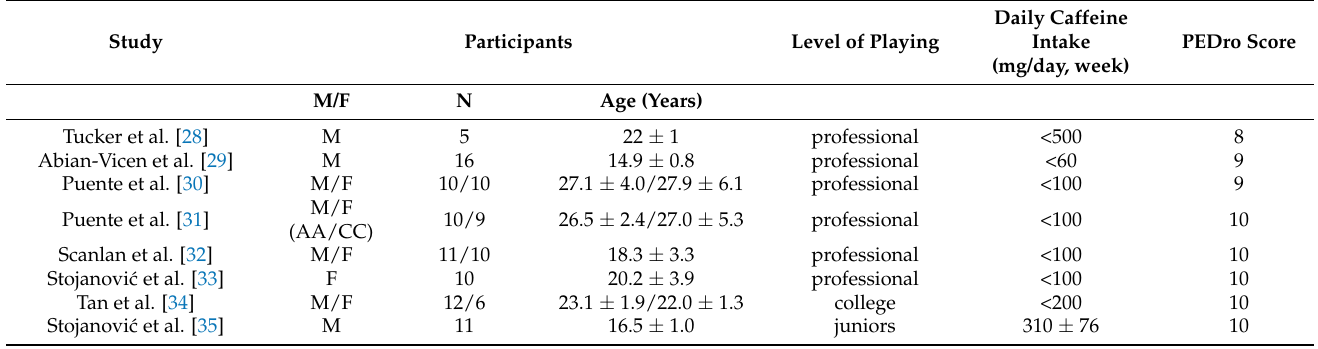
Figure 1. PRISMA preferred reporting items for systematic reviews and meta-analysis. Table 1. Descriptive statistics of the participants and PEDro scale for assessing quality of included studies.